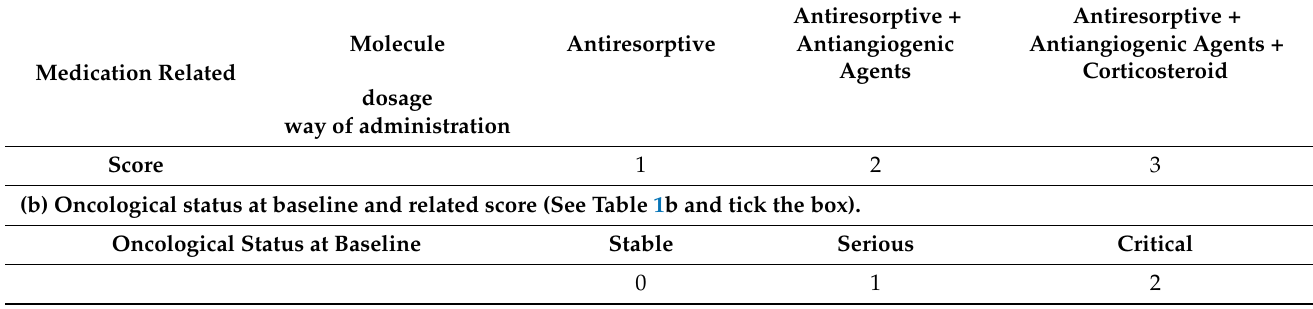
Table 1. (a): Pharmacological related score; Medium risk (1) antiresorptive drugs (Zometa 4 mg iv, Denosumab 120 mg sc). High risk (2) antiresorptive drugs+ angiogenesis inhibitors. Severe risk (3) antiresorptive drugs+ agiogenesis inhibitors+ corticosteroid and/or chemotherapy; (b): Oncological status at baseline and related score. Stable (0): bone disease only. No critical locations. Hormone therapy preferred. Low delay the start of treatment could be planned. Antiresorptive therapy could be delayed until dental health is optimized. Serious (1): systemic disease not life threatening, bone metastases not critical, minimize delay to definitive treatment.